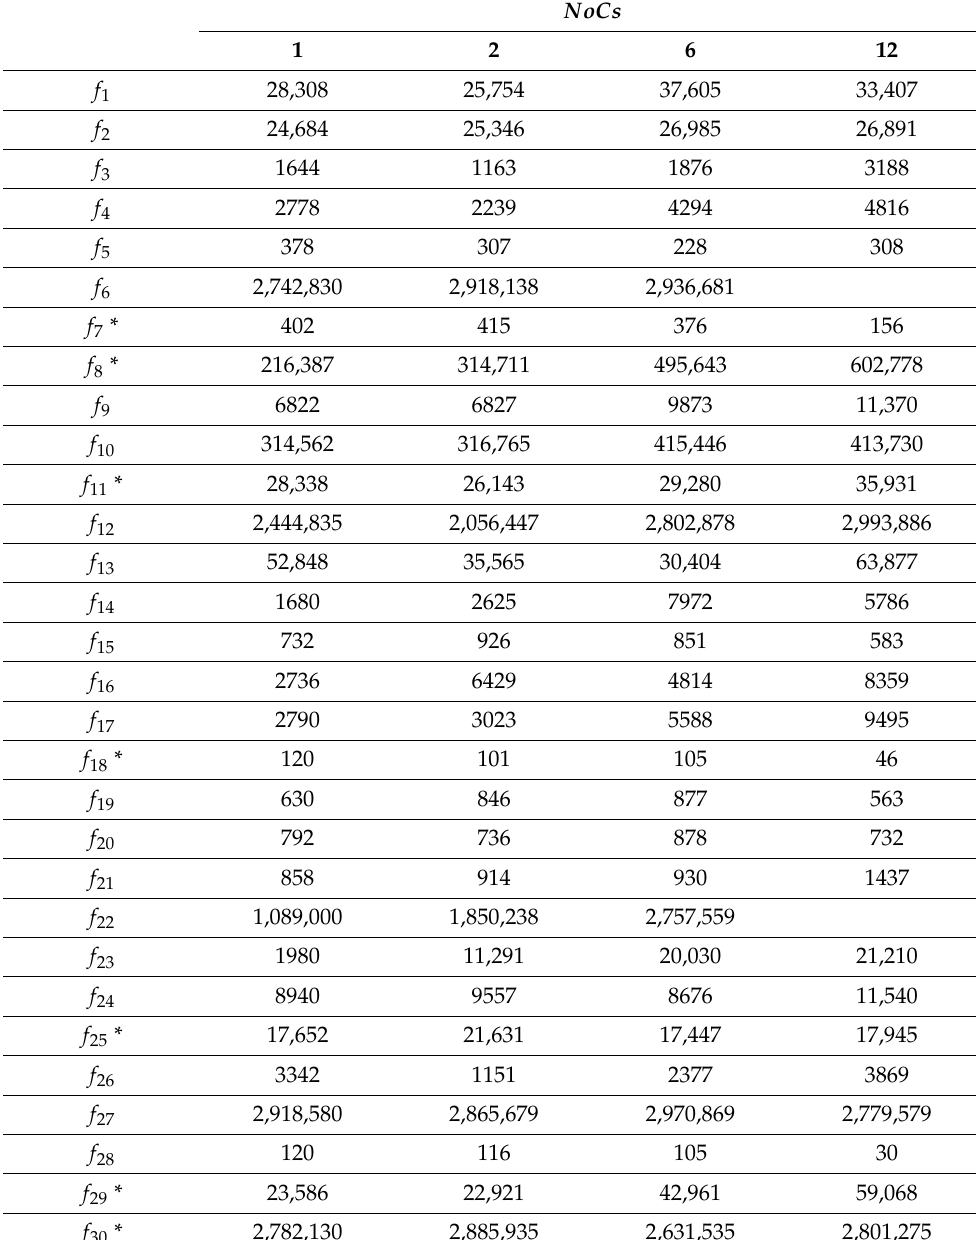
Table 12. Asynchronous parallel algorithm: number of function evaluations for error <1 × 10 − 3 (* < 1 × 10 2 ). popInitSize =